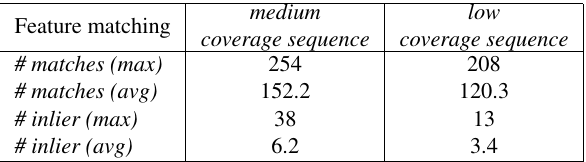
Table 3: Evaluation of feature matching on the medium and low coverage sequence . The number of matches by SURF and inlier matches between test images and nearest training images accord- ing to BoVW from the Real data set are depicted. The test images are assigned to their nearest training images by BoVW. On aver- age 152.2 respectively 120.3 matches between a test image and its nearest training image could be found. However, the num- ber of average inlier with 6.2 respectively 3.4 is unsatisfying for subsequently image